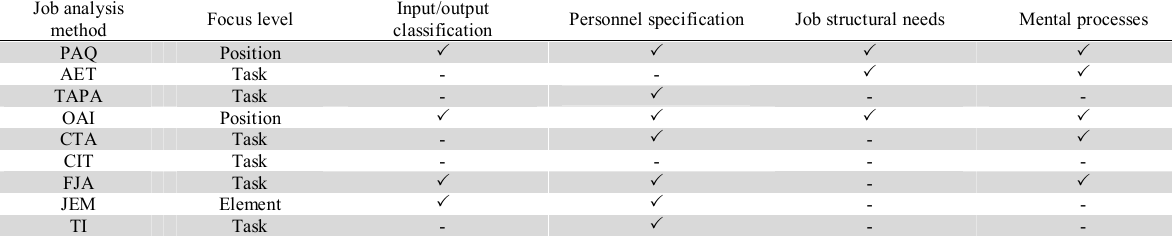
Job analysis methods and their attributes (Madani, 2007)